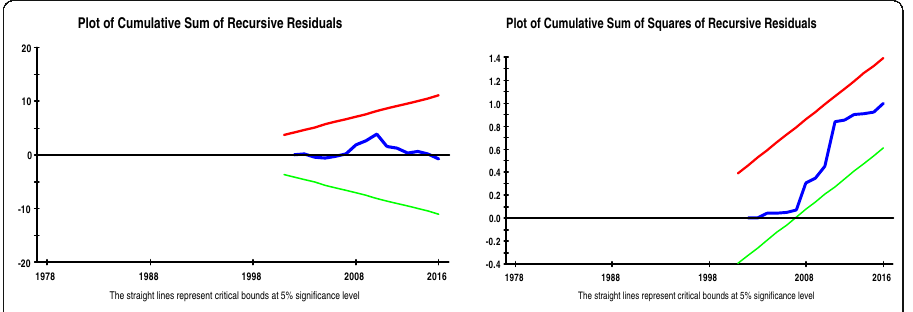
Fig. 2 CUSUM and CUSUMSQ plots for the stability